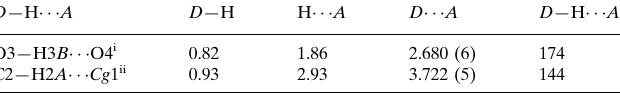
Hydrogen-bond geometry (A˚ , (cid:2)